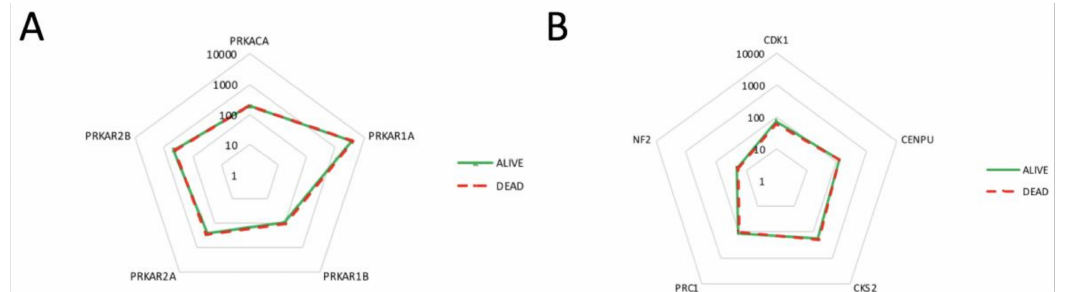
Figure 5. Expression levels of di ff erent genes in patients still alive or dead at the end of the study. ( A ) The expression level of the PKA regulatory and catalytic genes does not di ff er between dead and alive patients. ( B ) The expression level of five meningioma-related genes does not di ff er between dead and alive patients. Log10